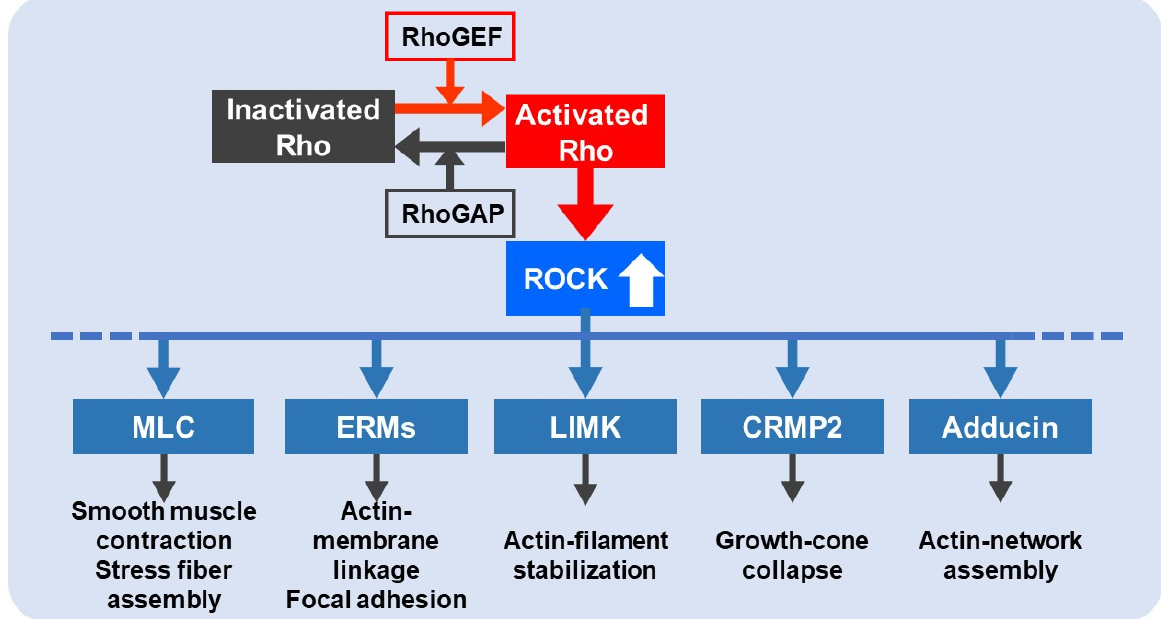
Figure 1. Representative downstream effectors of the Rho/ROCK pathway involved in fundamental biological roles in cellular function. RhoGEF: Rho guanine nucleotide exchange factor; RhoGAP: Rho GTPase activating protein; MLC: myosin light chain; ERM: ezrin/radixin/moesin; LIMK: LIM kinase; CRMP2: collapsin response mediator protein 2.